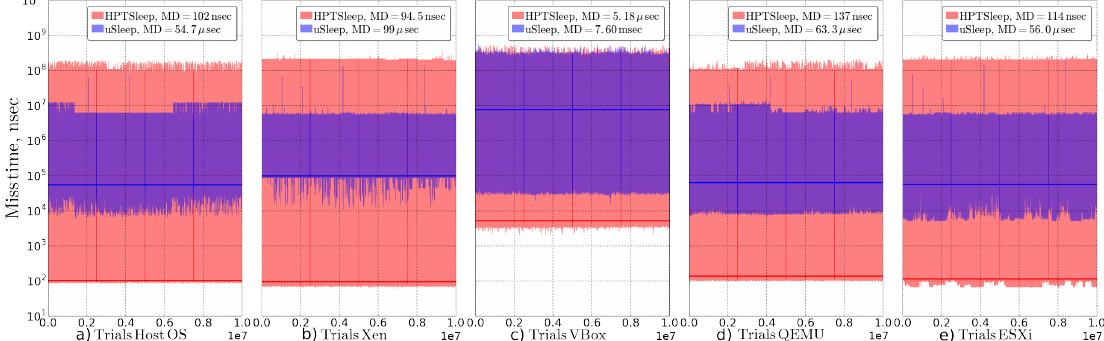
Figure 12. Measurements of miss time for the CPU testbed on: ( a ) Host OS; ( b ) Xen; ( c ) Virtual Box; ( d ) QEMU; and ( e ) VMware